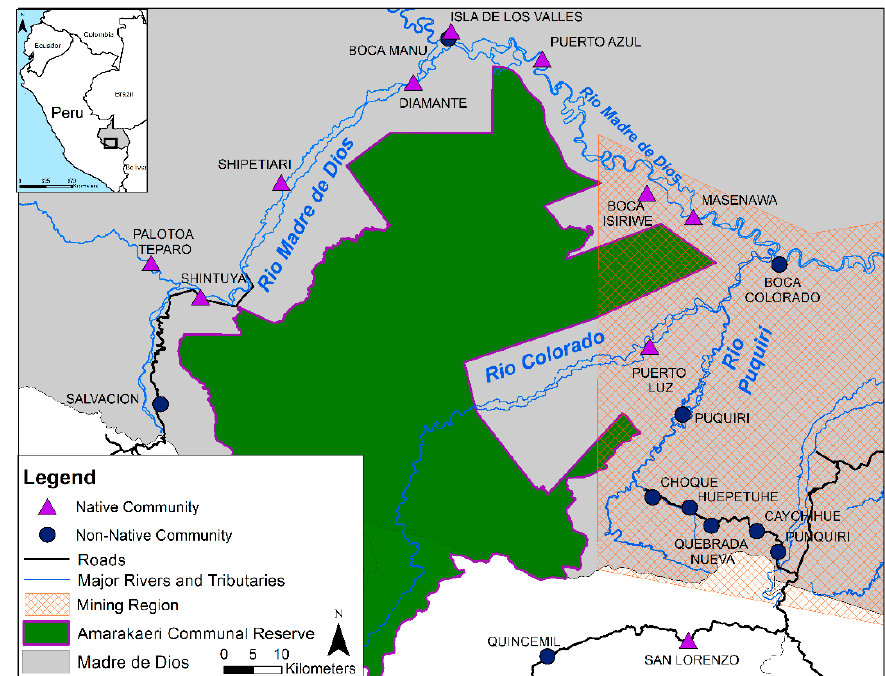
Figure 1. Map of the study area in MDD, Peru. Communities along the river were distinguished based on residence within ASGM (orange hashed zone) or outside ASGM (grey and white zones). Households were visited between 2015 and 2016 for collection of hair samples.